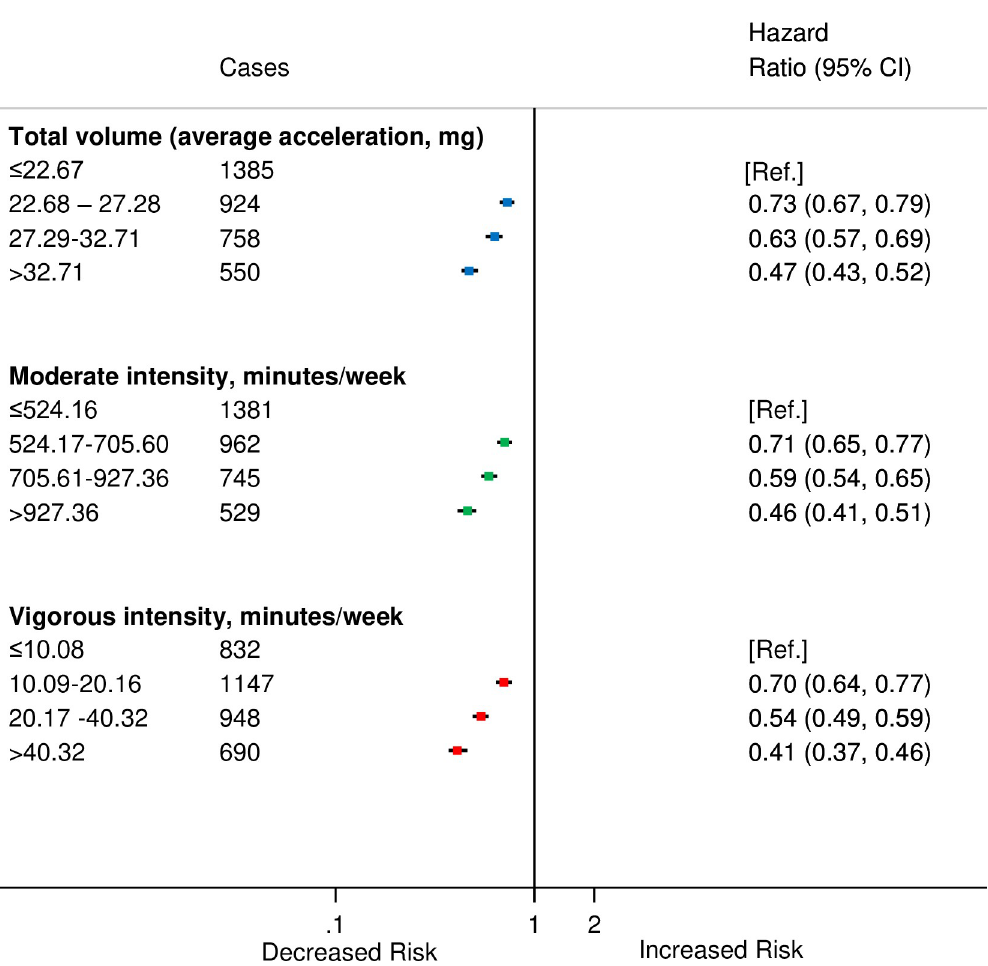
Fig 1. HRs a for incident CVD by quarters of average accelerometer-measured total volume, moderate-intensity and vigorous-intensity physical activities in 90,211 UK Biobank participants. a Adjusted for age (stratified by 5-year age-at-risk intervals), sex, ethnicity, education, Townsend Deprivation Index, smoking, and alcohol consumption. CI, confidence interval; CVD, cardiovascular disease; HR, hazard